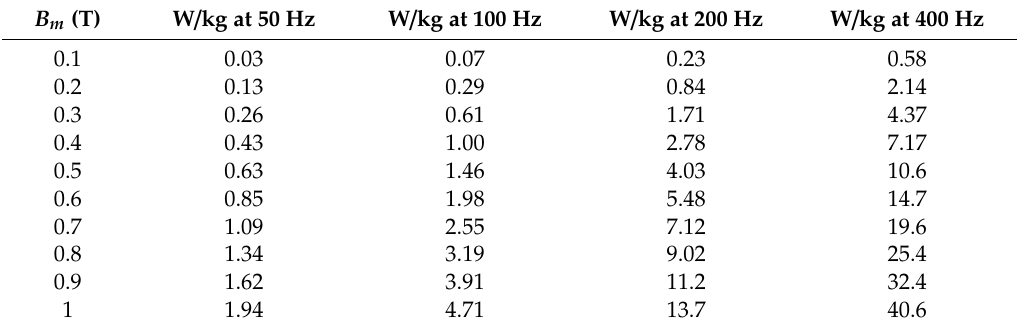
Table 3. Manufacturer’s loss data for M470-50HP electrical steel. Adapted with permission from [66], Cogent Power Inc.,